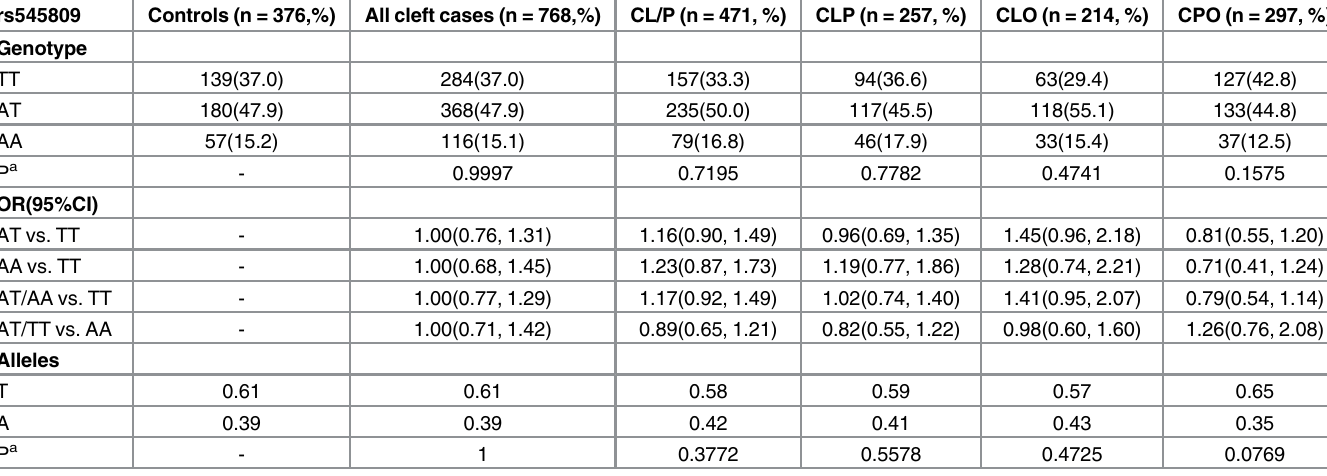
Table 3. Genotypic and allelic distributions of rs545809 in NSOFC cases and controls.